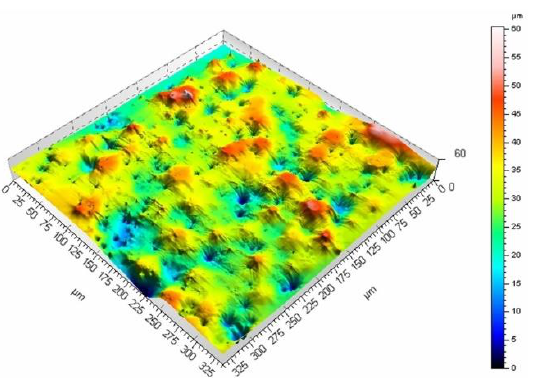
Figure 9. Surface morphology produced from a pulse duration of 60 ns and velocity of 400 mm/s.